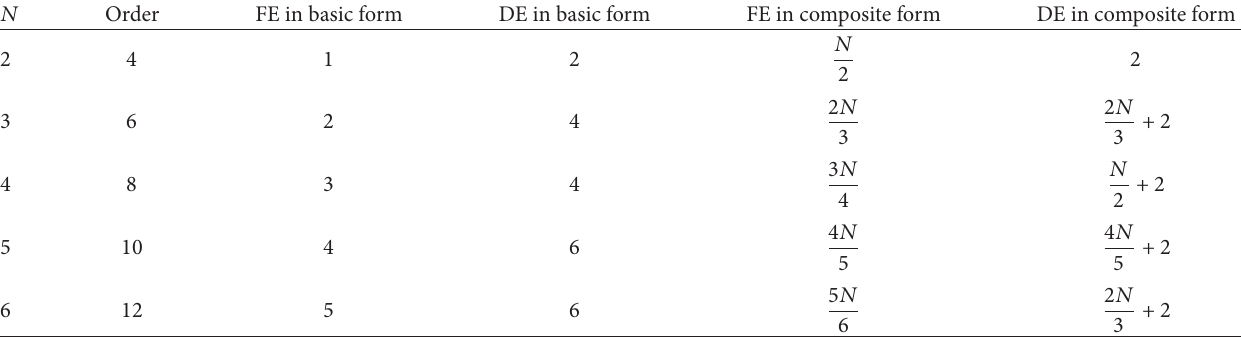
Table 4: Computational cost for ONC2.